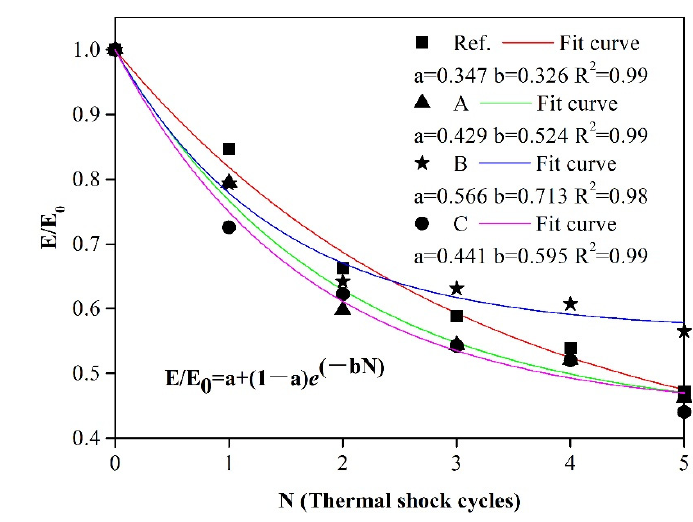
Figure 8. Thermal fatigue resistance (TFR) behavior of castables.